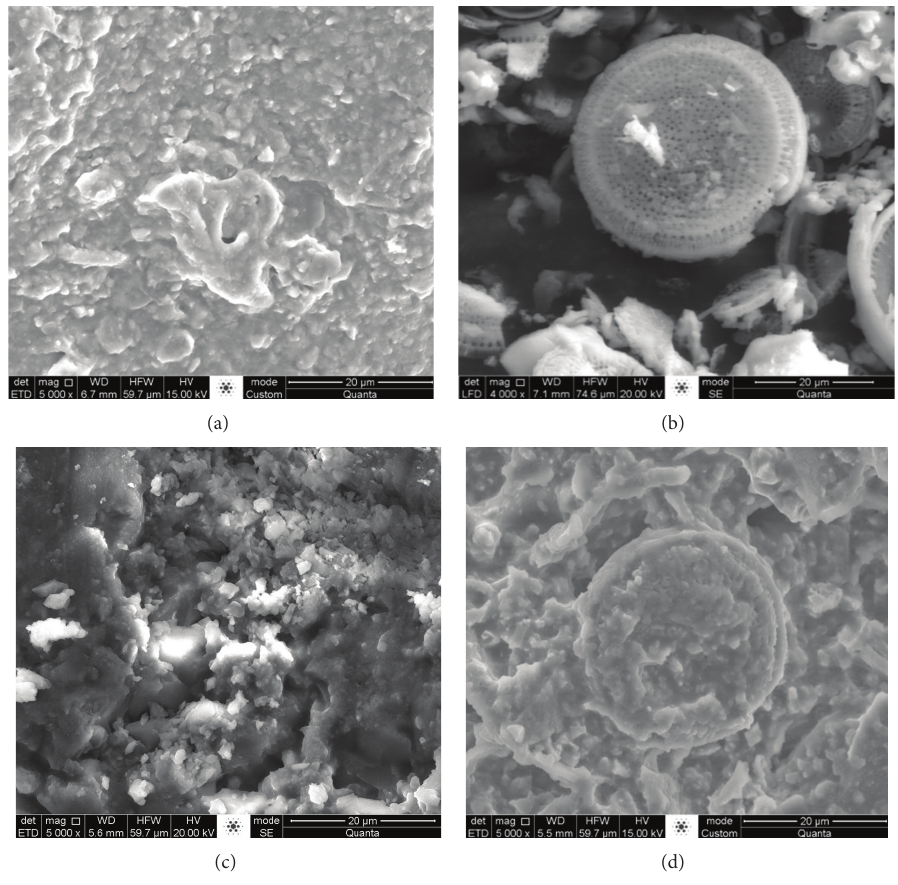
Figure 2: SEM images of Fe 70 , Fe 60 , K 2 FeO 4 , and diatomite samples ((a) K 2 FeO 4 ; (b) diatomite; (c) F 60 ; and (d) F 70